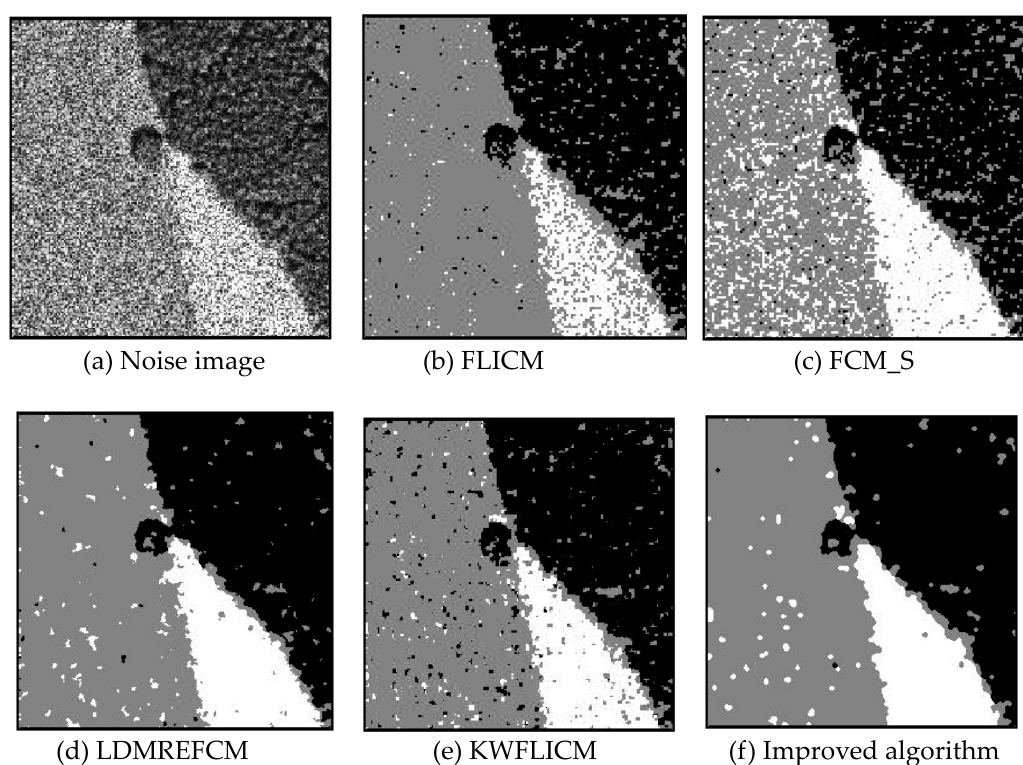
Figure 11. Multiplicative noise disturbing remote sensing image 3 ( a ) and the segmentation results ( b – f ).